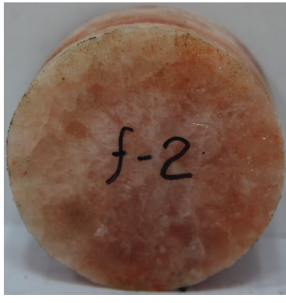
Figure 1: Salt rock